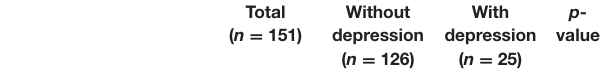
TABLE 1 | Baseline characteristics of patients with end-stage renal disease enrolled in this study.